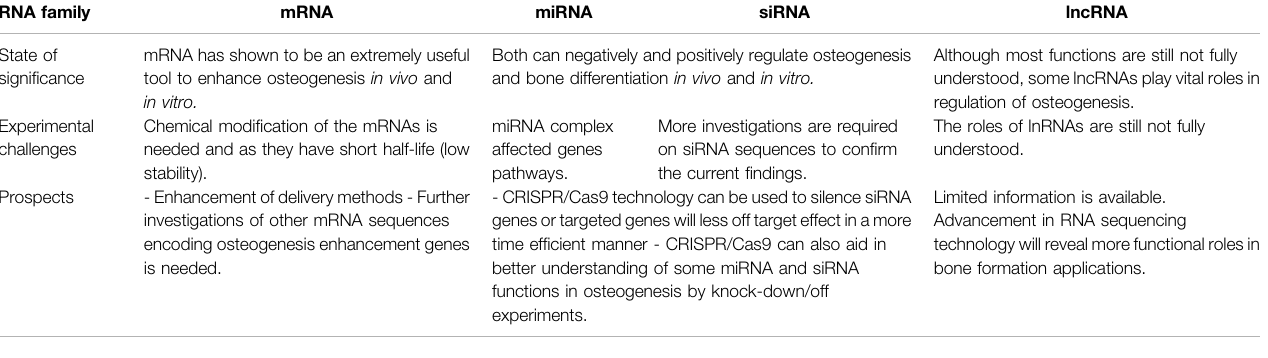
TABLE 6 | State of signi fi cance, experimental challenges and prospects of mRNA-, RNAi-and lncRNA-based therapy for bone osteogenesis. RNA family mRNA